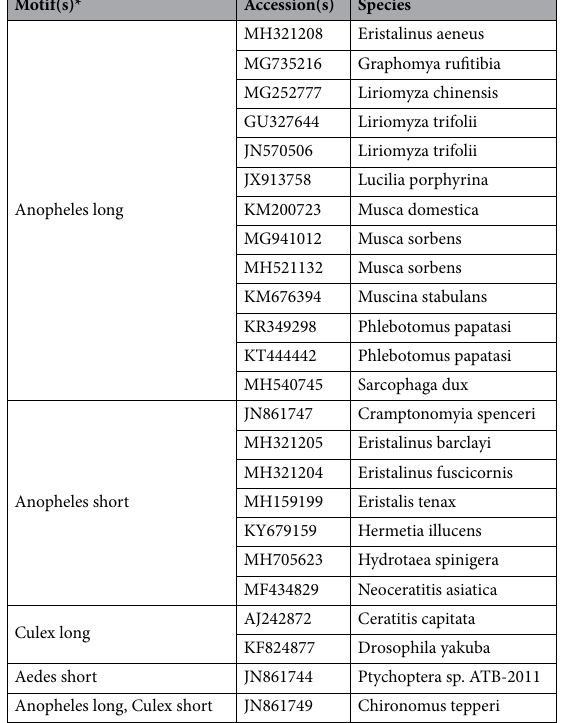
Table 5. Non-Culicidae Dipteran sequences with the conserved mosquito mitogenome control region motifs in the mitogenome control region between 80 and 210 bp upstream of the 12S rRNA gene. *Motifs were counted if MAST found the motif on the majority strand, and the starting point was between 83 and 165 bp (for Long motifs) or 130–210 bp (for Short motifs) upstream of the end of the 12S rRNA